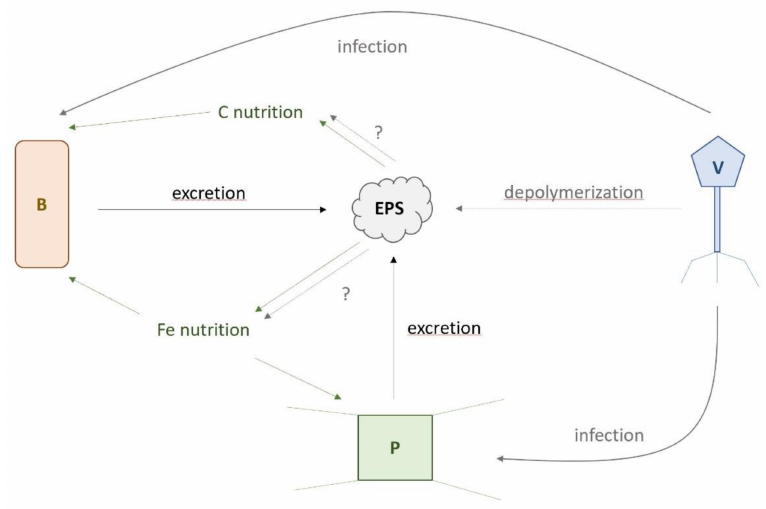
Figure 8. Schematic representation of potential interactions between viruses (V), prokaryotes (B), and plankton (P) in relationship to infection (blue), the role of exopolymeric substances (EPS) in carbon (C) and iron (Fe) nutrition (red), and EPS excretion as a result of cell lysis and biological activity (green). The role of viral depolymerization of EPS and their unknown impact (?) on C and Fe nutrition are shown with short dashed blue